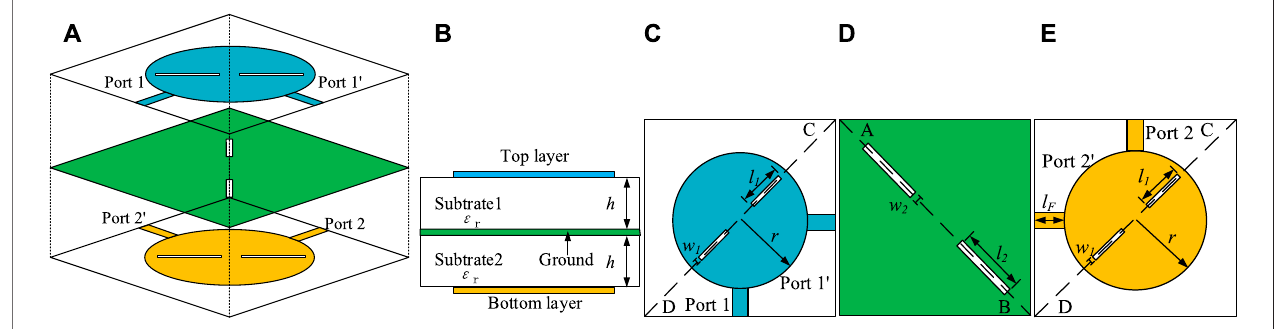
FIGURE 1 | (A) 3D view of the proposed dual-band balanced fi lter, (B) side view, (C) top layer, (D) middle layer, and (E) bottom layer.